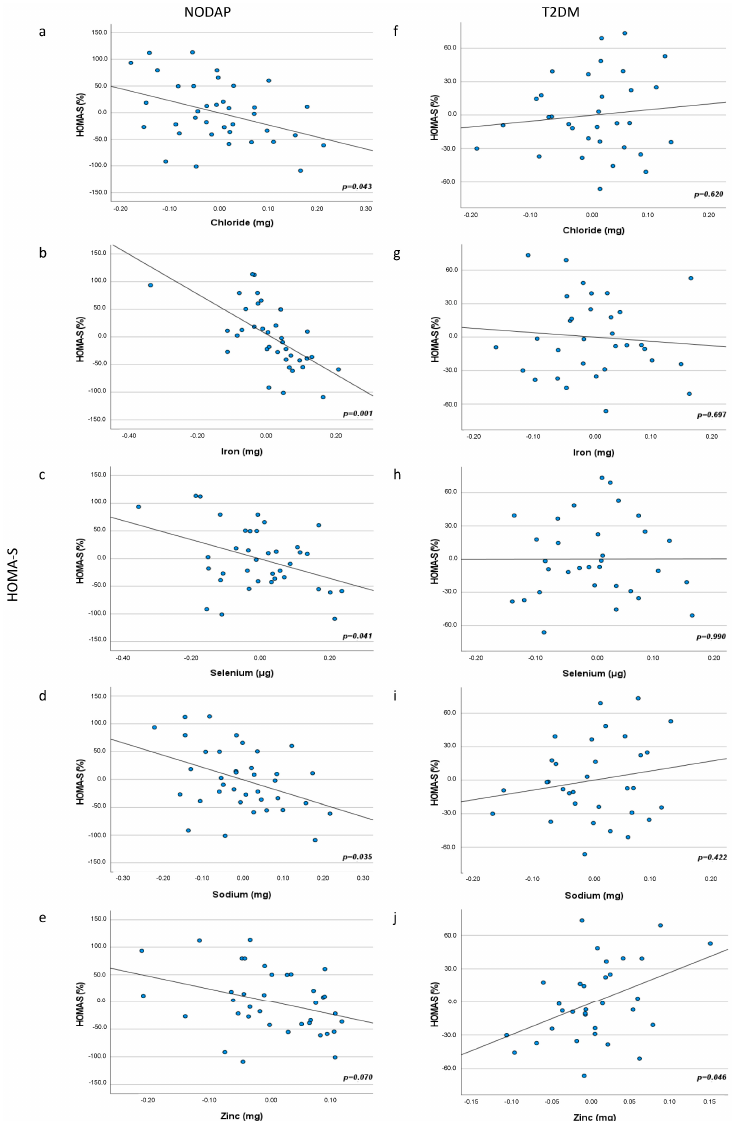
Figure 3. Associations between chloride, iron, selenium, sodium, and zinc intake and HOMA-S in NODAP ( a–e ) and T2DM ( f–j ). Abbreviations: NODAP = New-onset diabetes or prediabetes after acute pancreatitis. T2DM = Type 2 diabetes or prediabetes prior to acute pancreatitis. HbA1c = glycated haemoglobin. Chloride, iron, selenium, sodium, and zinc data were log transformed. Partial regression plots were adjusted for age, sex, daily energy intake, V/S fat volume, alcohol intake, smoking status, aetiology of AP, number of AP episodes, cholecystectomy, use of antidiabetic medications. Significance was set at p <